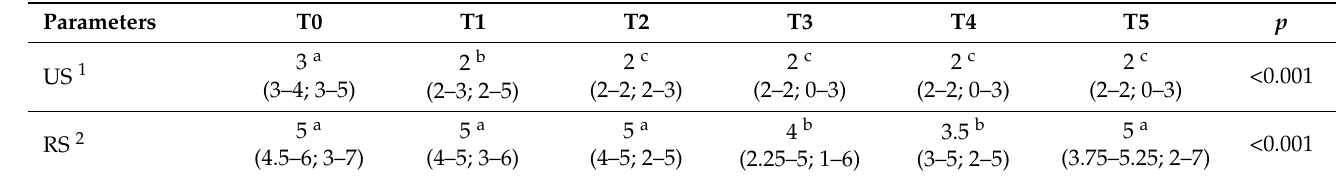
Table 3. Parameters’ trend of group D (n = 31) at T0 (Time 0; day of restocking), T1 (Time 1; after 1.5 days), T2 (Time 2; after 3 days), T3 (Time 3; after 7 days), T4 (Time 4; after 14 days), and T5 (Time 5; after 21 days). Data are expressed as median (1st quartile–3rd quartile; minimum value–maximum value) and mean ±